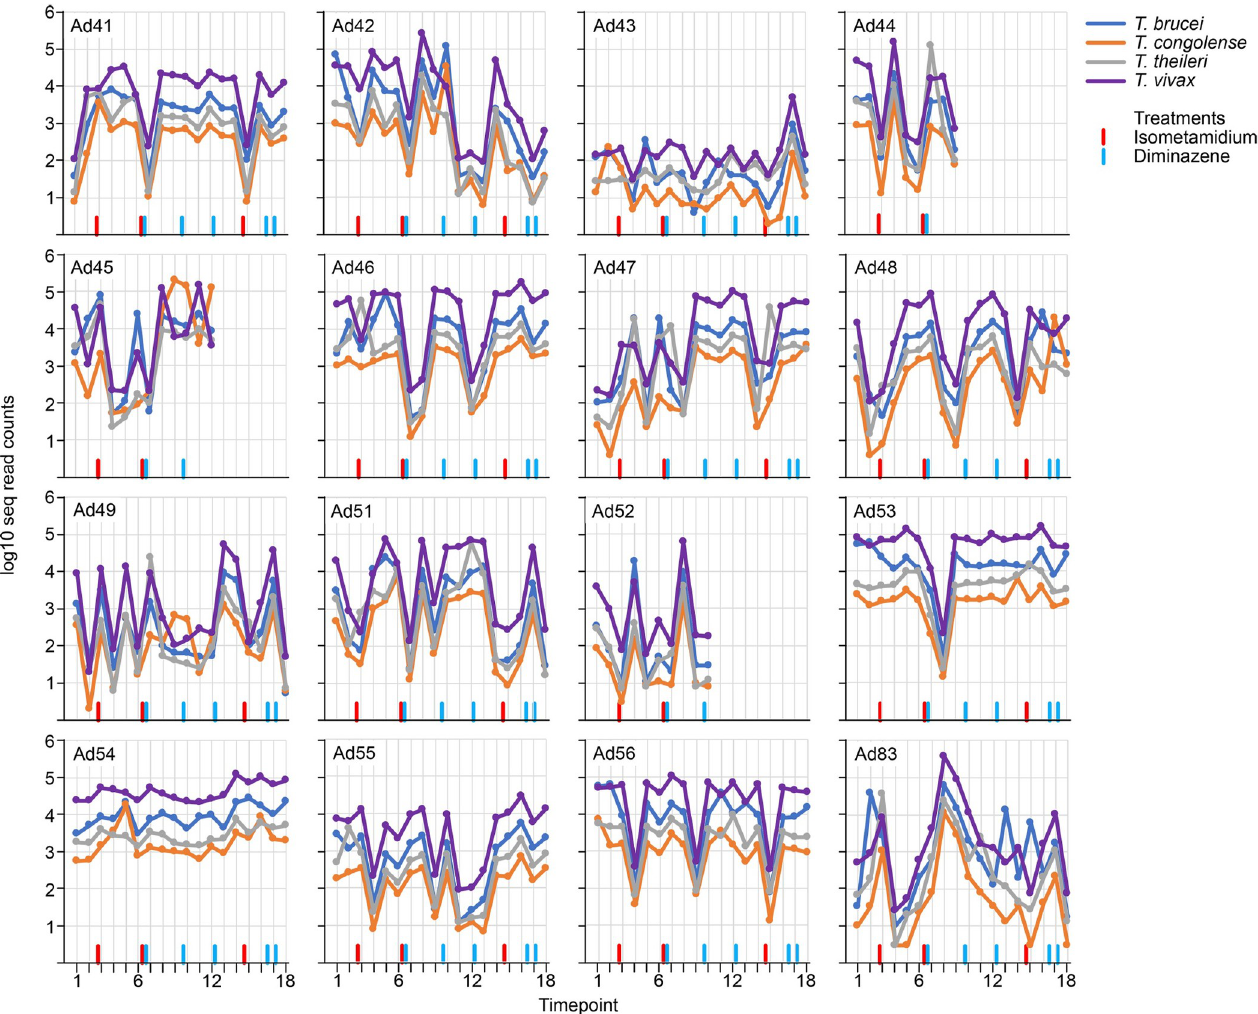
Fig 4. Infections of individual cattle with the different species of trypanosome over two years in Adidome. The colour code for each species is indicated: blue, T . brucei ; orange, T . congolense ; grey, T . theileri ; purple, T . vivax . The timing of drug treatments at Adidome is indicated on the x-axis: blue, diminazene; red, isometamidium. The y-axis is a logarithmic